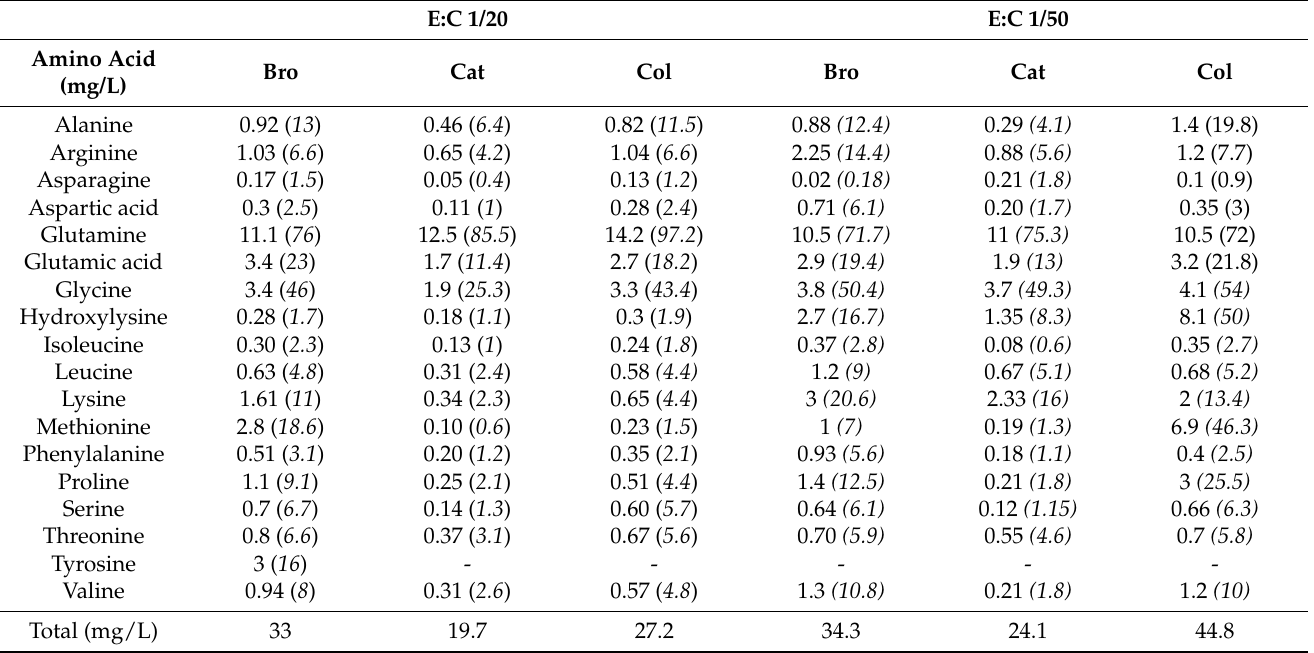
Figure 1. Collagen peptides concentration according to the enzyme, to the ratio enzyme/collagen and to the molecular weight of the fraction (mean ± standard deviation). Columns label interpretation: (i) lowercase letters indicate differences among enzymes for the ratio 1/20 and for the <3000 Da fraction; (ii) different uppercase letters indicate differences among enzymes for the ratio 1/20 and for the fraction >3000 Da; (iii) different Greek letters indicate differences among enzymes for the ratio 1/50 and for the <3000 Da fraction; (iv) different numbers indicate differences among enzymes for the ratio 1/50 and for the> 3000 Da fraction; (v) different symbols indicate differences between the ratios 1/20 and 1/50, for each fraction. Table 3. Free amino acids composition (mg/L) for the <3000 Da peptides-minerals complexes fractions obtained by bromelain (Bro), cathepsin B (Cat) and collagenase B (Col) (values in brackets express concentration in µ